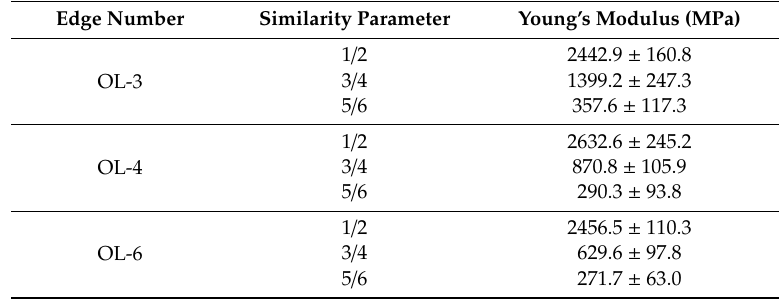
Figure 11. Comparision of stress–strain and Young’s modulus. ( a ) Stress–strain curves of OL-3; ( b ) stress–strain curves of OL-4; ( c ) stress–strain curves of OL-6; ( d ) Ccmparision of Young’s modulus. Table 2. Young’s modulus.